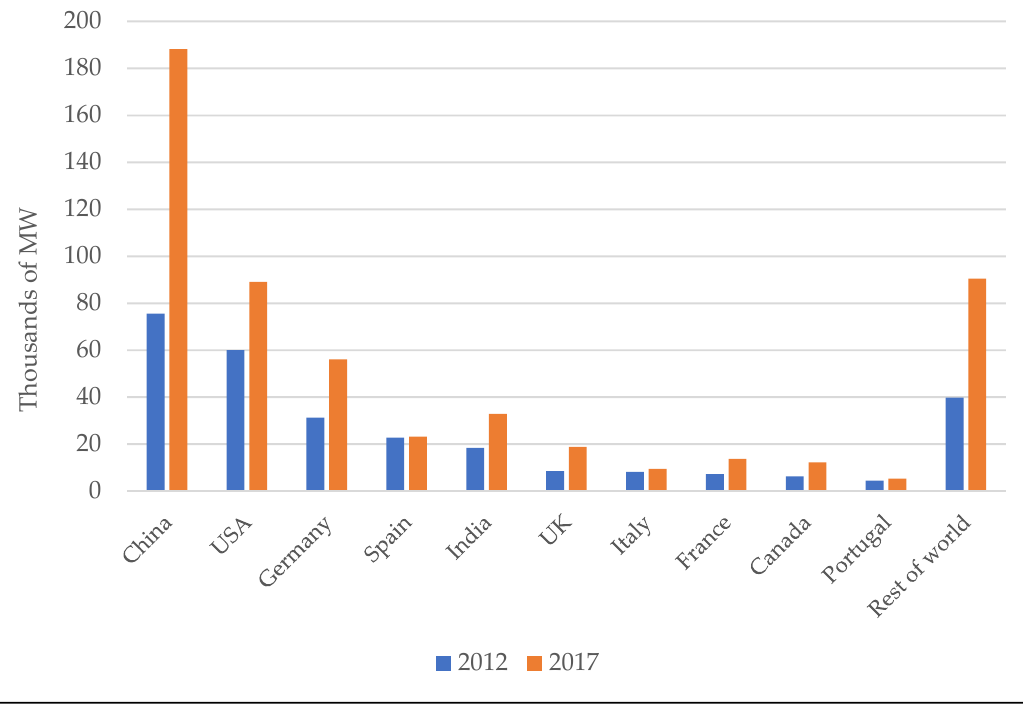
Figure 2. Installed capacity of wind power in thousands of MW. Years 2012 and 2017 [1].